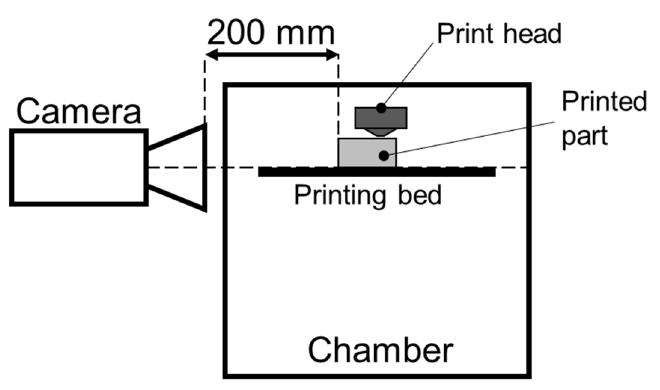
Figure 6. Schematics of the infrared camera placement with respect to the printed part.